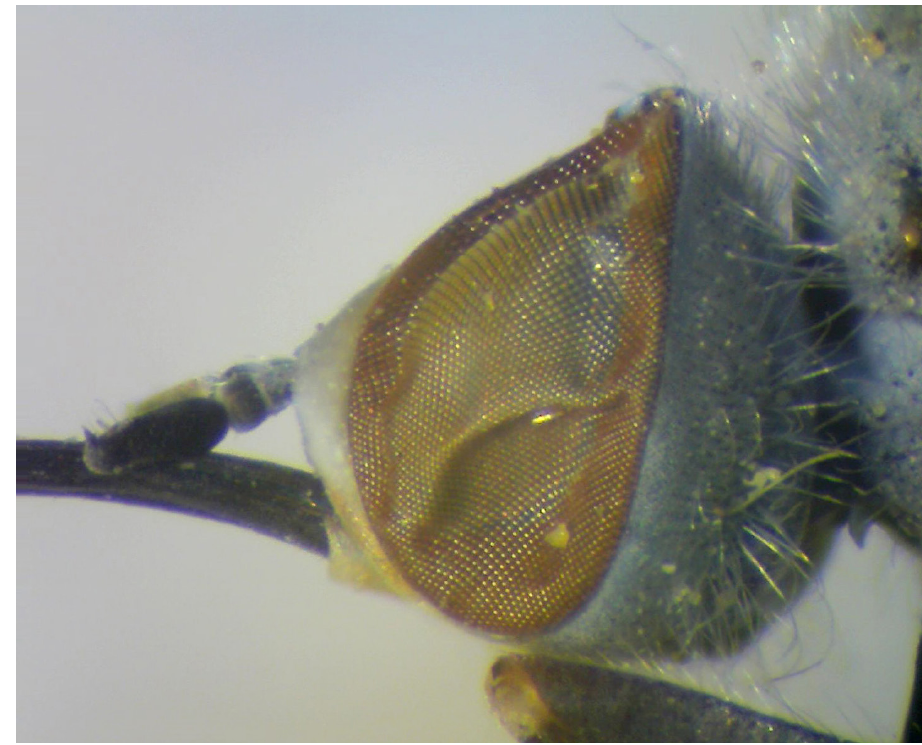
Fig. 6. Protypusia negevi (Zaitzev, 1996) gen. et comb. nov., ♂.